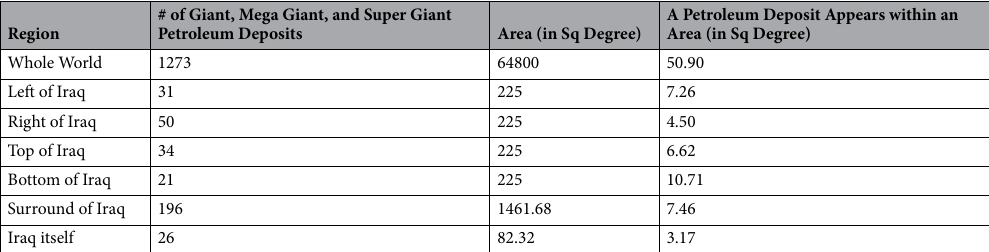
Table 2. The density of giant, mega-giant, and super-giant petroleum deposits in our training and testing regions.